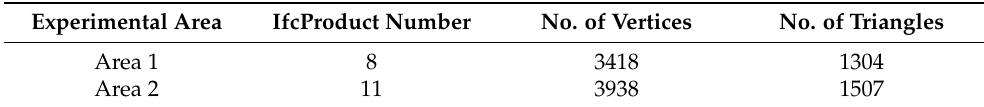
Figure 13. Results of the proposed method. ( a ) Area 1 and ( b ) area 2 of Figure 11.